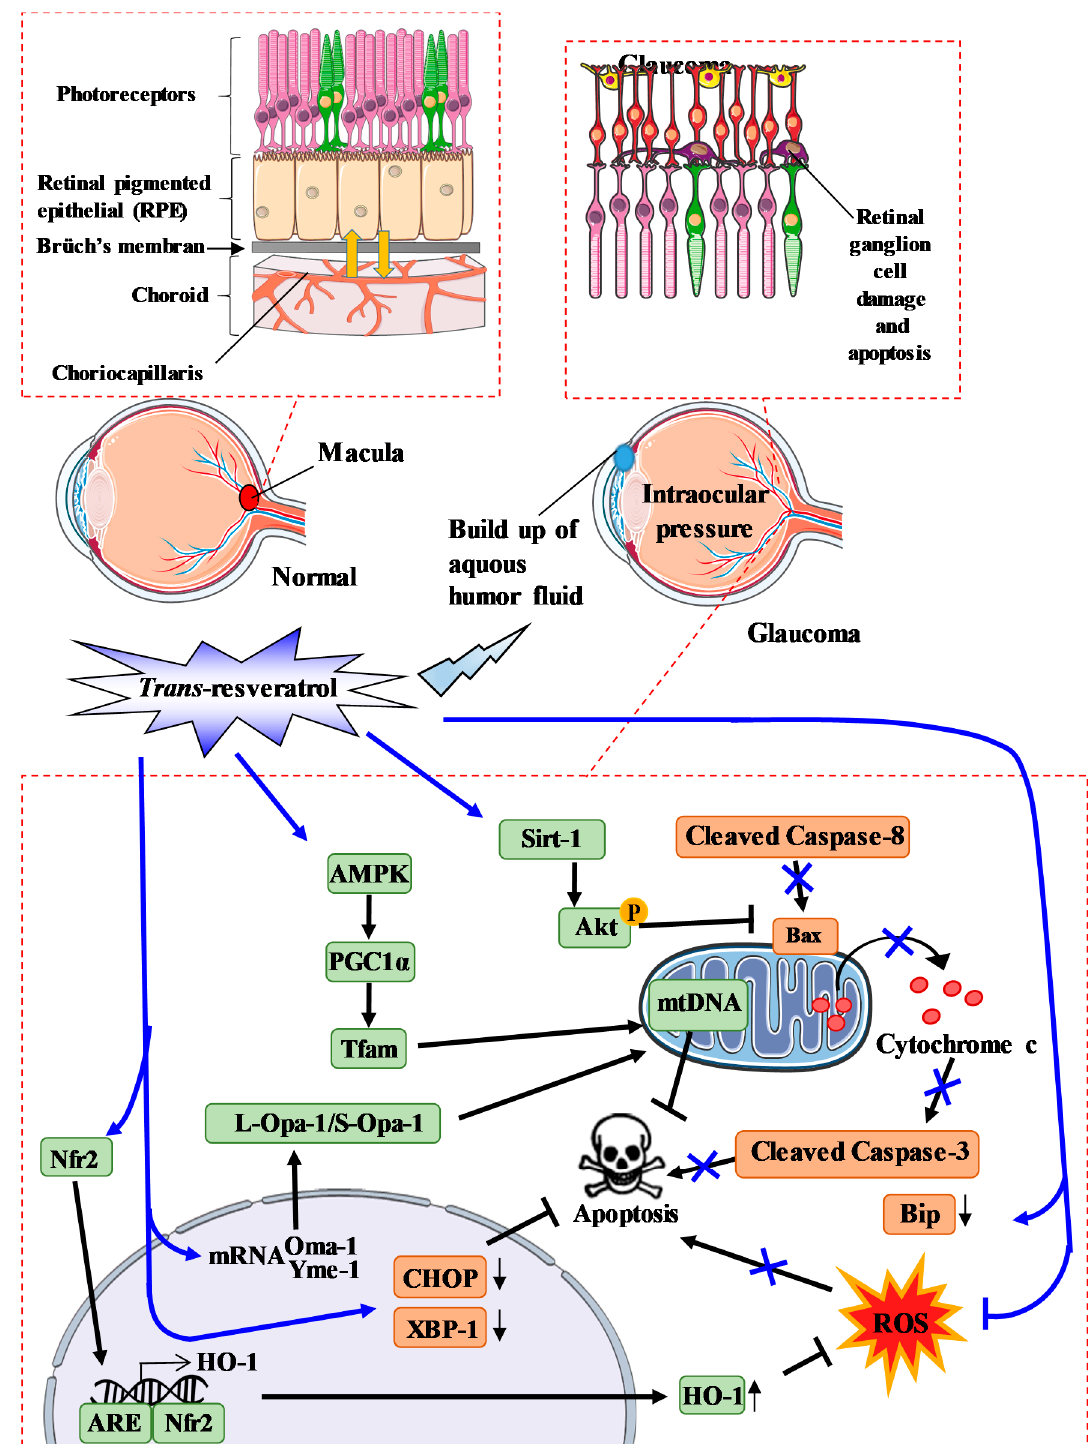
Figure 4. Proposed model of resveratrol action during oxidative stress in glaucoma. Trans -resveratrol (RSV) activates sirtuin-1 (Sirt-1), which leads to the phosphorylation of Akt and inhibits Bax activity. RSV also activates the AMPK pathway, which leads to mitochondrial DNA transcription and replication. RSV is also able to alter Oma-1 and Yeme-1 mRNA expression, leading to the alteration of the L-Opa-1/S-Opa-1 (long-optical autophagy 1/short optical autophagy) ratio. In addition, RSV also lowers ROS levels not only by activating the scavenger pathway, but also by facilitating the translocation of Nrf2 into the nucleus, thereby favoring interaction between Nfr2 and the antioxidant response element (ARE) leading to HO-